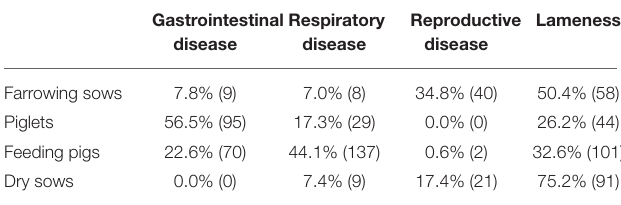
TABLE 2 | Frequency of reported disease conditions requiring antimicrobial treatment in different groups of pigs on farms in the year preceding the questionnaire